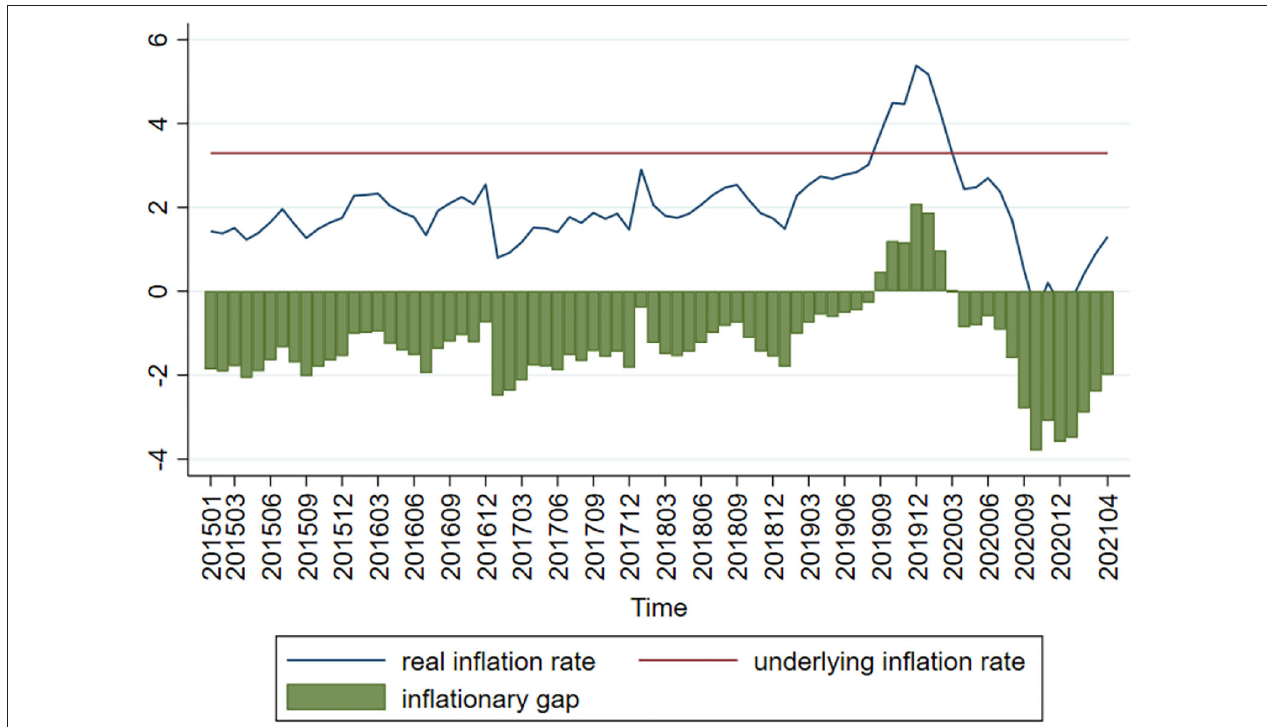
FIGURE 5 | Inflationary gap chart.